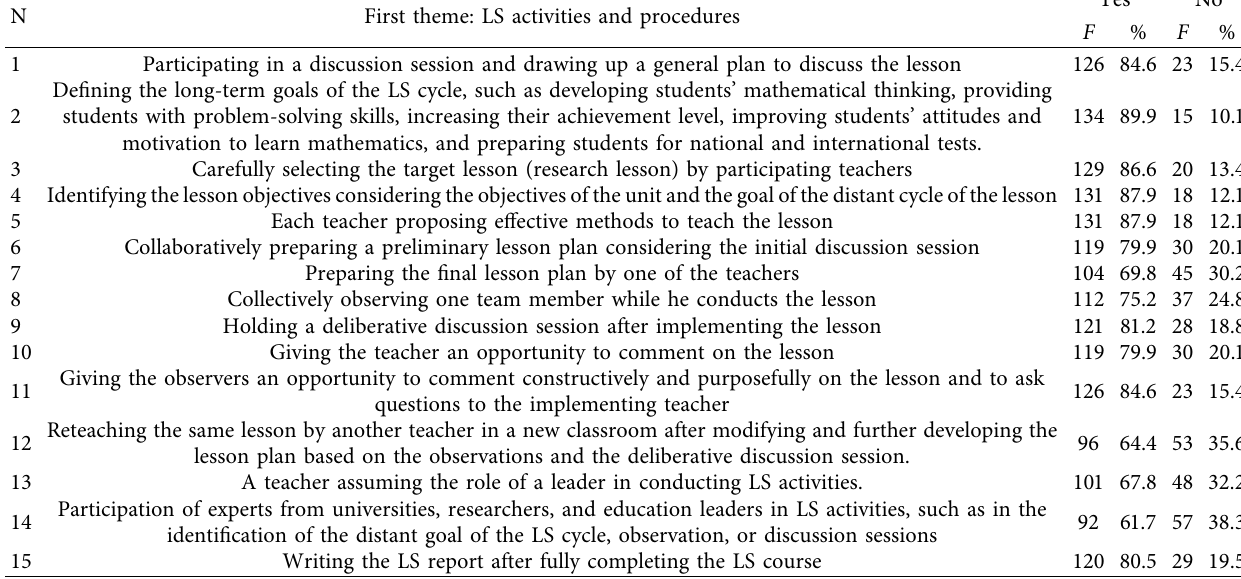
Table 1: Descriptive statistics for lesson study (LS) activities and procedures. First theme: LS activities and